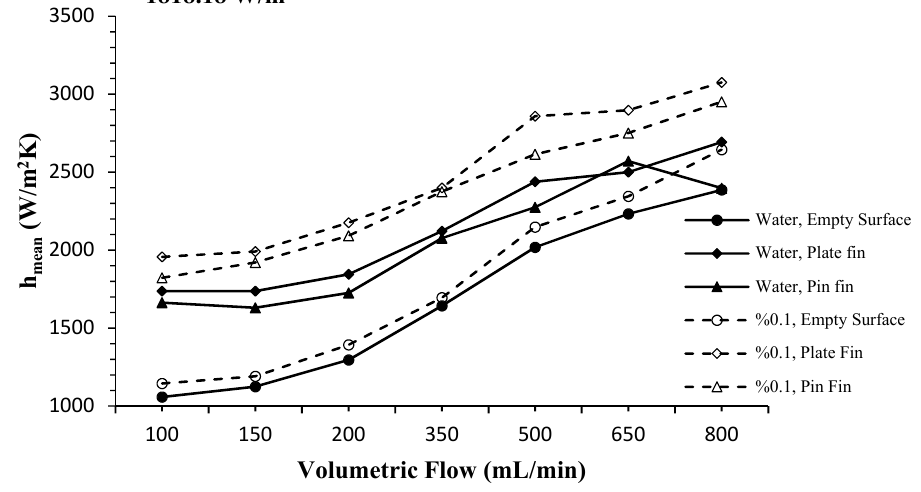
Figure 7. Variation of the mean convective heat transfer coefficients with volumetric flow rates. The variations of the mean Nusselt number with different volumetric flow rates at 1818.18 W/m 2 is given in Figure 8. It was observed that the mean Nusselt number for all cases increased as the volumetric flow rate increased. By using both nanofluid and finned surfaces, the amount of heat that was transferred from the surfaces was found to be higher than the base fluid. The results that were obtained from the use of nanofluid